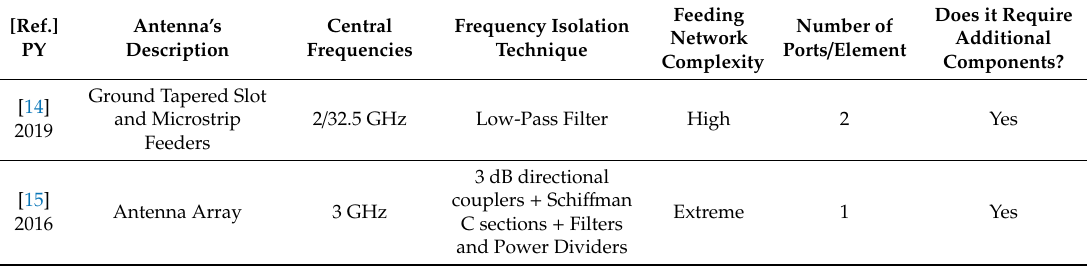
Table 6. State-of-the-Art in Frequency Selective Antenna Structures: Main